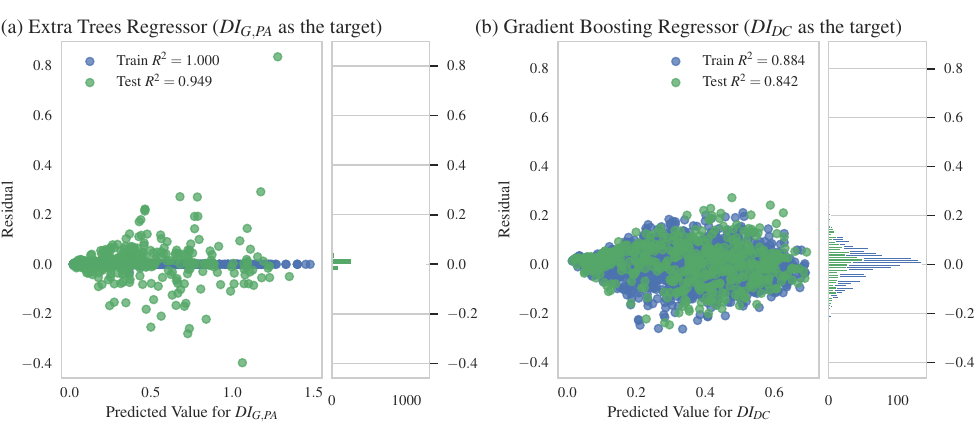
Figure 11. Residuals of the MLAs with the best predictive capacity for ( a ) the prediction of DI G,PA and ( b ) the prediction of DI DC